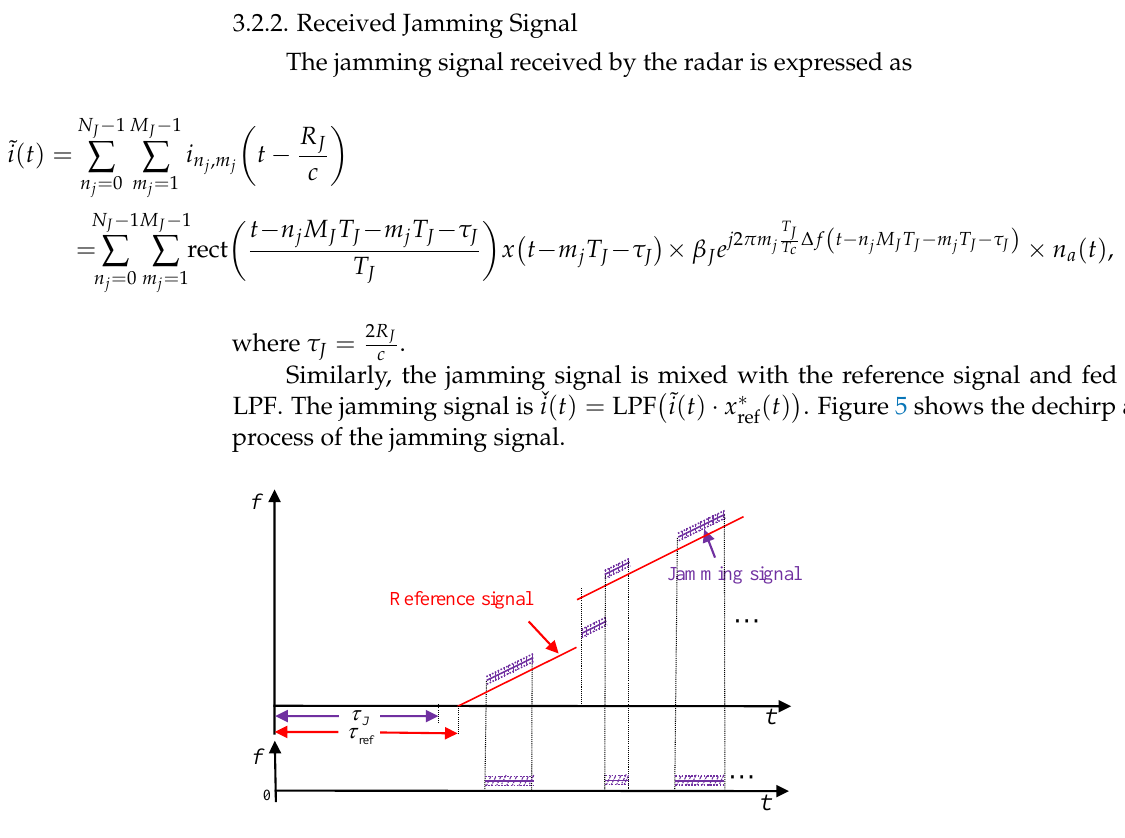
Figure 4. The working process of the jammer.